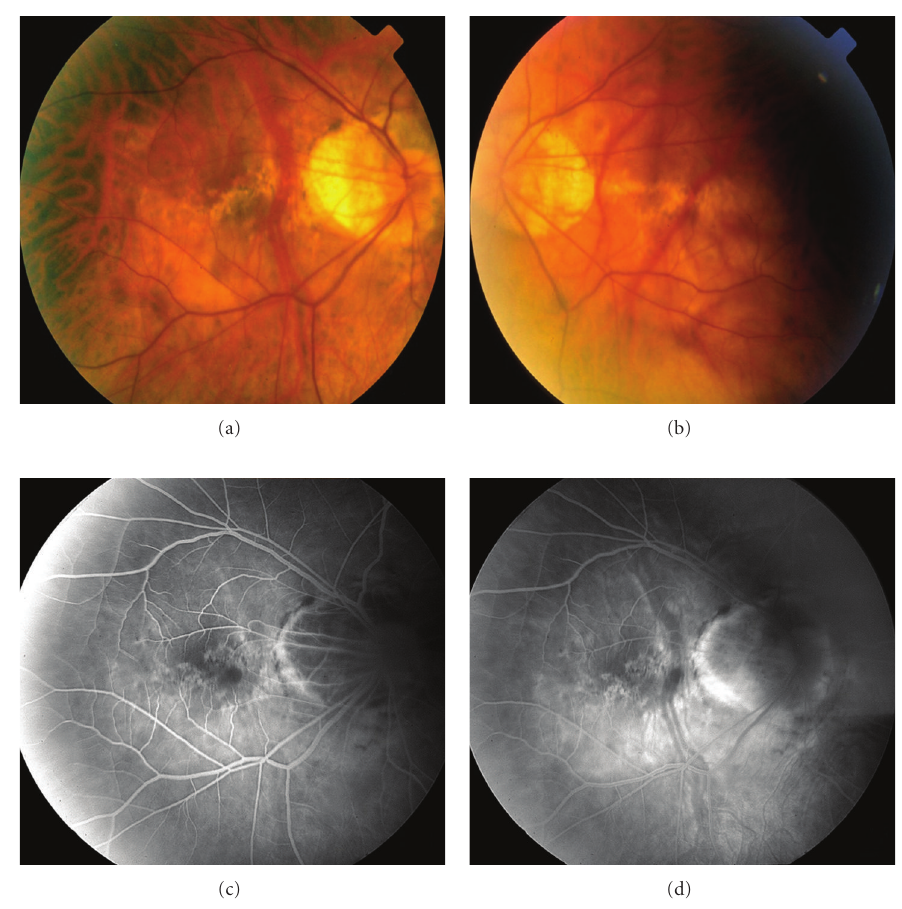
Figure 1: (a) Clinical photographs of the fundus of the right and (b) left eyes. Bilateral optic nerve crescents and staphylomas are seen in both eyes. There are also degenerative changes seen in the macular areas of both eyes. (c) Fluorescein angiogram of the right eye in the early (a) and late (b) phases demonstrating staining of the optic nerve crescents and small window defects along the macular region.